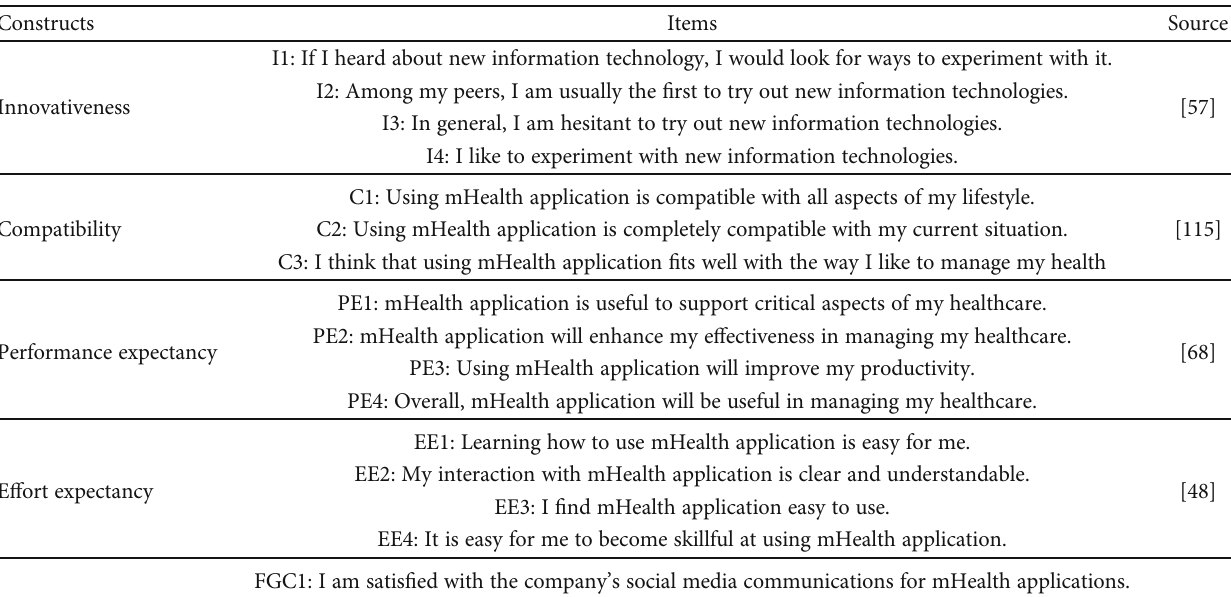
Table 2: Questionnaire items of each